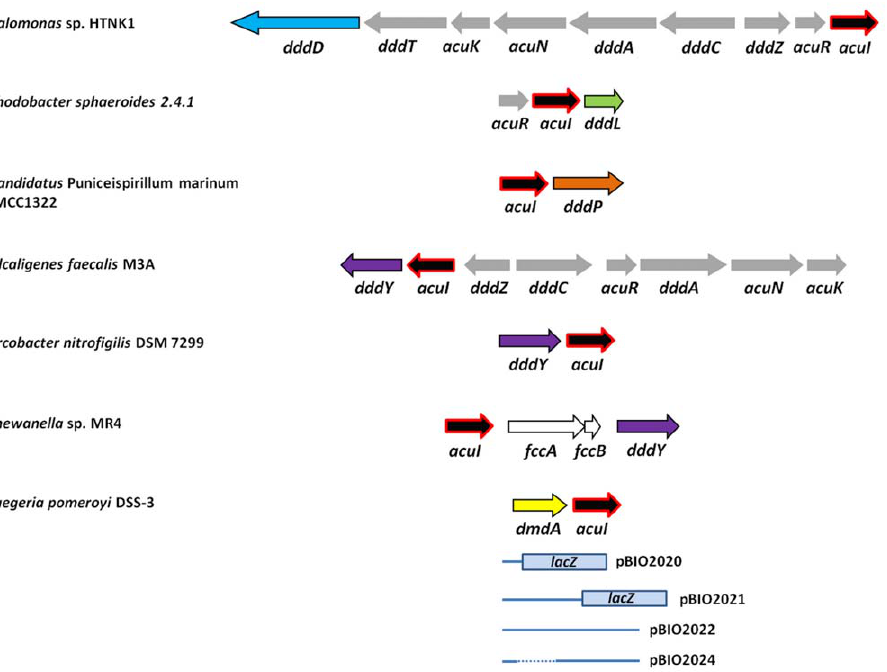
Figure 1. Locations of acuI relative to various ddd and dmdA genes in different bacteria. Locations of the acuI genes relative to those that encode DMSP demethylase ( dmdA – yellow fill) or the ddd genes that encode the DddD, DddL, DddP and DddY DMSP lyases (arrows filled with various colors) are shown. Grey-filled arrows signify genes with other, known roles in DMSP catabolism. The fccA and fccB genes in Shewanella sp. MR4 encode a flavocytochrome c and a tetraheme cytochrome c respectively. Gene tags from left to right as shown above are: Halomonas HTNK1: ACV84065 to ACV84073 inclusive Rhodobacter sphaeroides 2.4.1: RSP_1433 to RSP_1435 inclusive Canididatus Puniceispirillum marinum IMCC1322: SAR116_1428, SAR116_1427 Alcaligenes faecalis M3A: ADT64689 to ADT64696 inclusive Arcobacter nitrofigilis DSM 7299: Arnit_0113, Arnit_0112 Shewanella sp. MR4: Shewmr4_2154 to Shewmr4_2151 inclusive Ruegeria pomeroyi DSS-3: SPO1913, SPO1914 Also shown are the dimensions of the Ruegeria pomeroyi DSS-3 dmdA-lacZ and acuI-lacZ fusion plasmids (pBIO2020 and pBIO2021 respectively) in which the reporter lacZ gene in pBIO1878. The cloned R. pomeroyi DNA (shown as blue lines) was cloned into pBIO1878 to form pBIO2022 ( acuI + dmdA ) and pBIO2024 ( dmdA alone) for the complementation